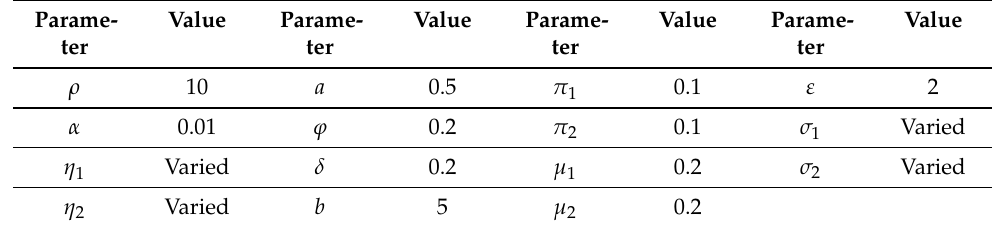
Table 3. The values of parameters of system